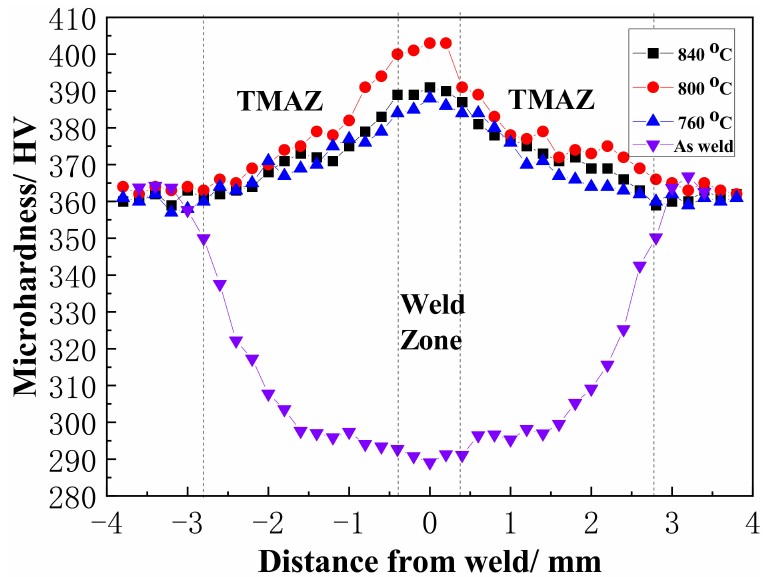
Figure 13. Microhardness profiles of the joint from weld zone to base metal under different aging